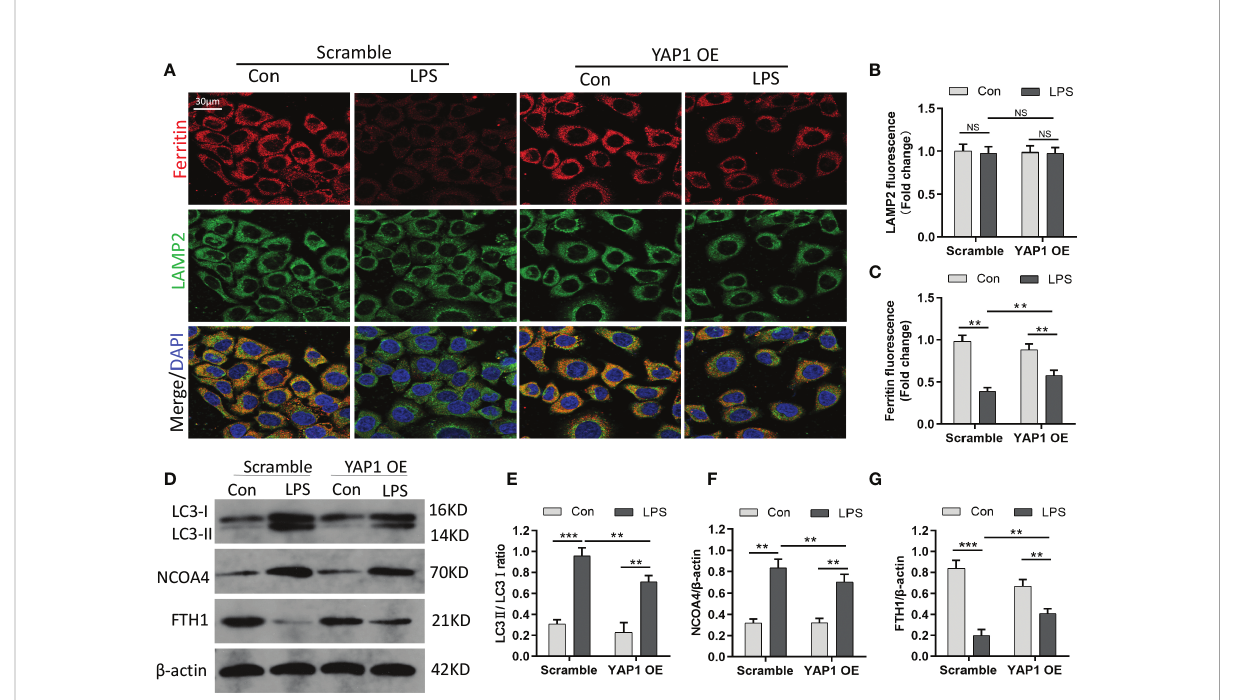
FIGURE 3 YAP1 restrained the degradation of ferritin in lysosomes to suppress ferritinophagy. (A) Confocal images of ferritin (red) and LAMP2 (green) were shown in LPS-treated MLE-12 cells, while lysosomes were stained with LAMP2 (green). (B) Quanti fi cation measurement of lysosome fl uorescence intensity. (C) Quanti fi cation measurement of ferritin fl uorescence intensity. (D – G) Data showed the expression contents of LC3II/ LC3I (E) , NCOA4 (F) , and FTH1 (G) . Data are expressed as mean ± SD. n = 3; * p < 0.05, ** p < 0.01, *** p < 0.001. NS: no signi fi cance,